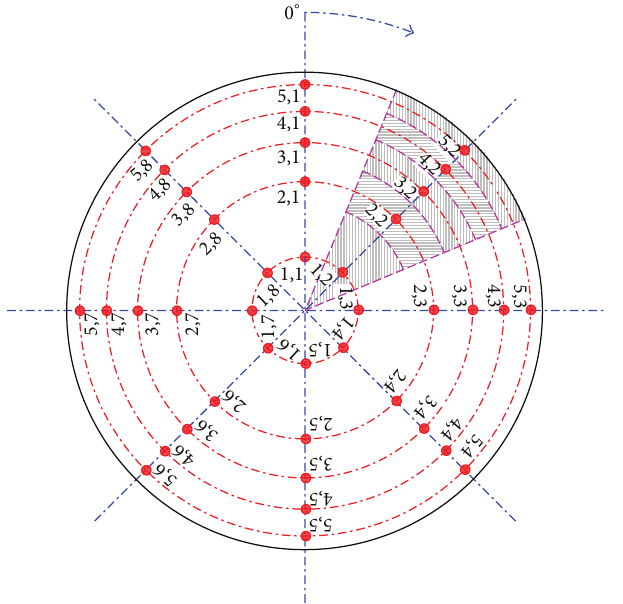
Figure 4: Total pressure loss, 𝜆 = 0.2 𝑀 1